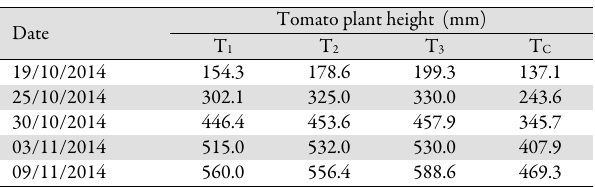
Results and Discussion